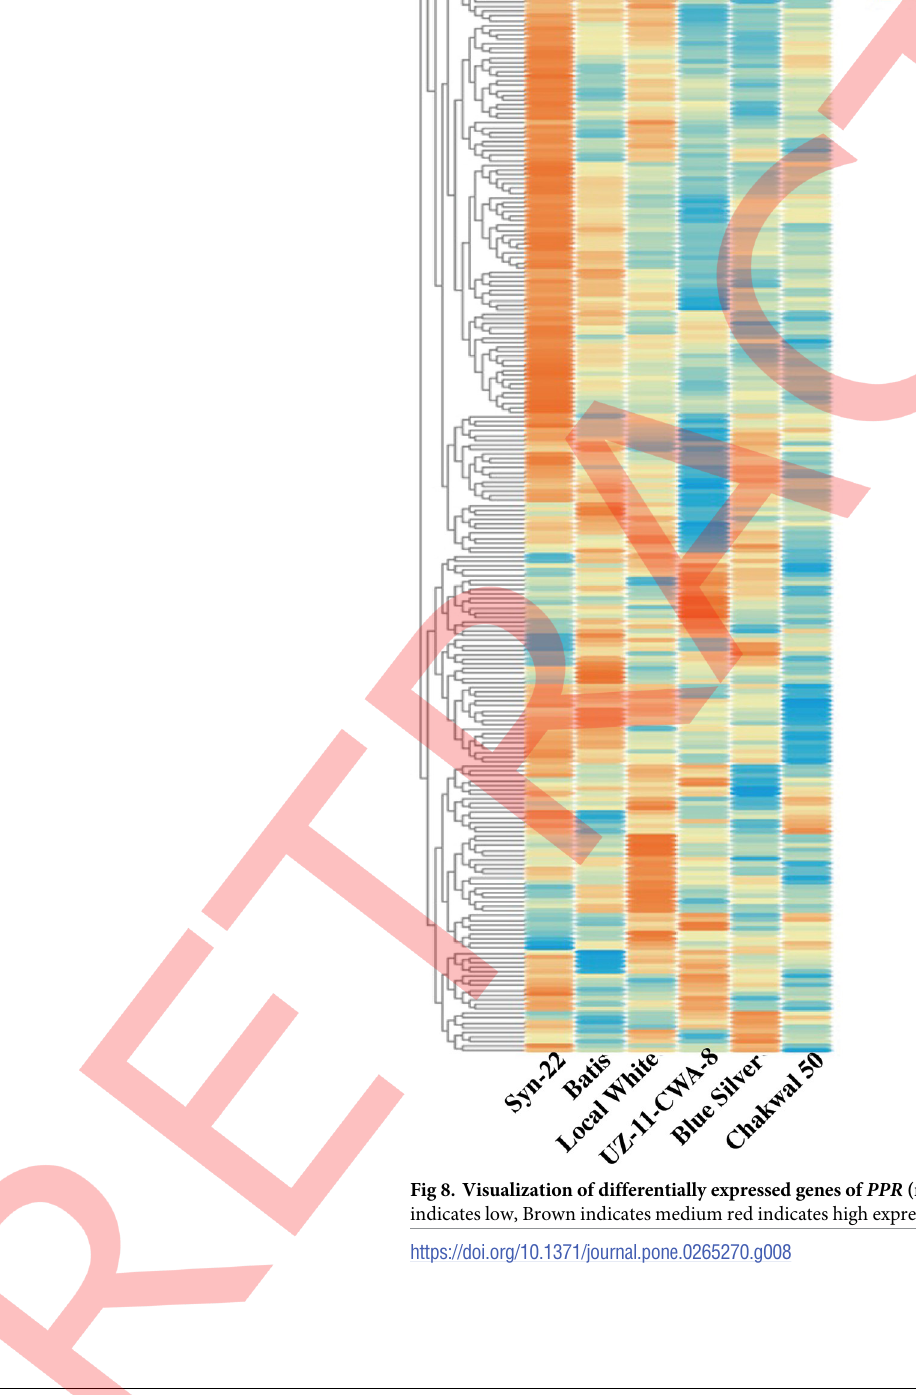
PLOS ONE | https://doi.org/10.1371/journal.pone.0265270 March 11,